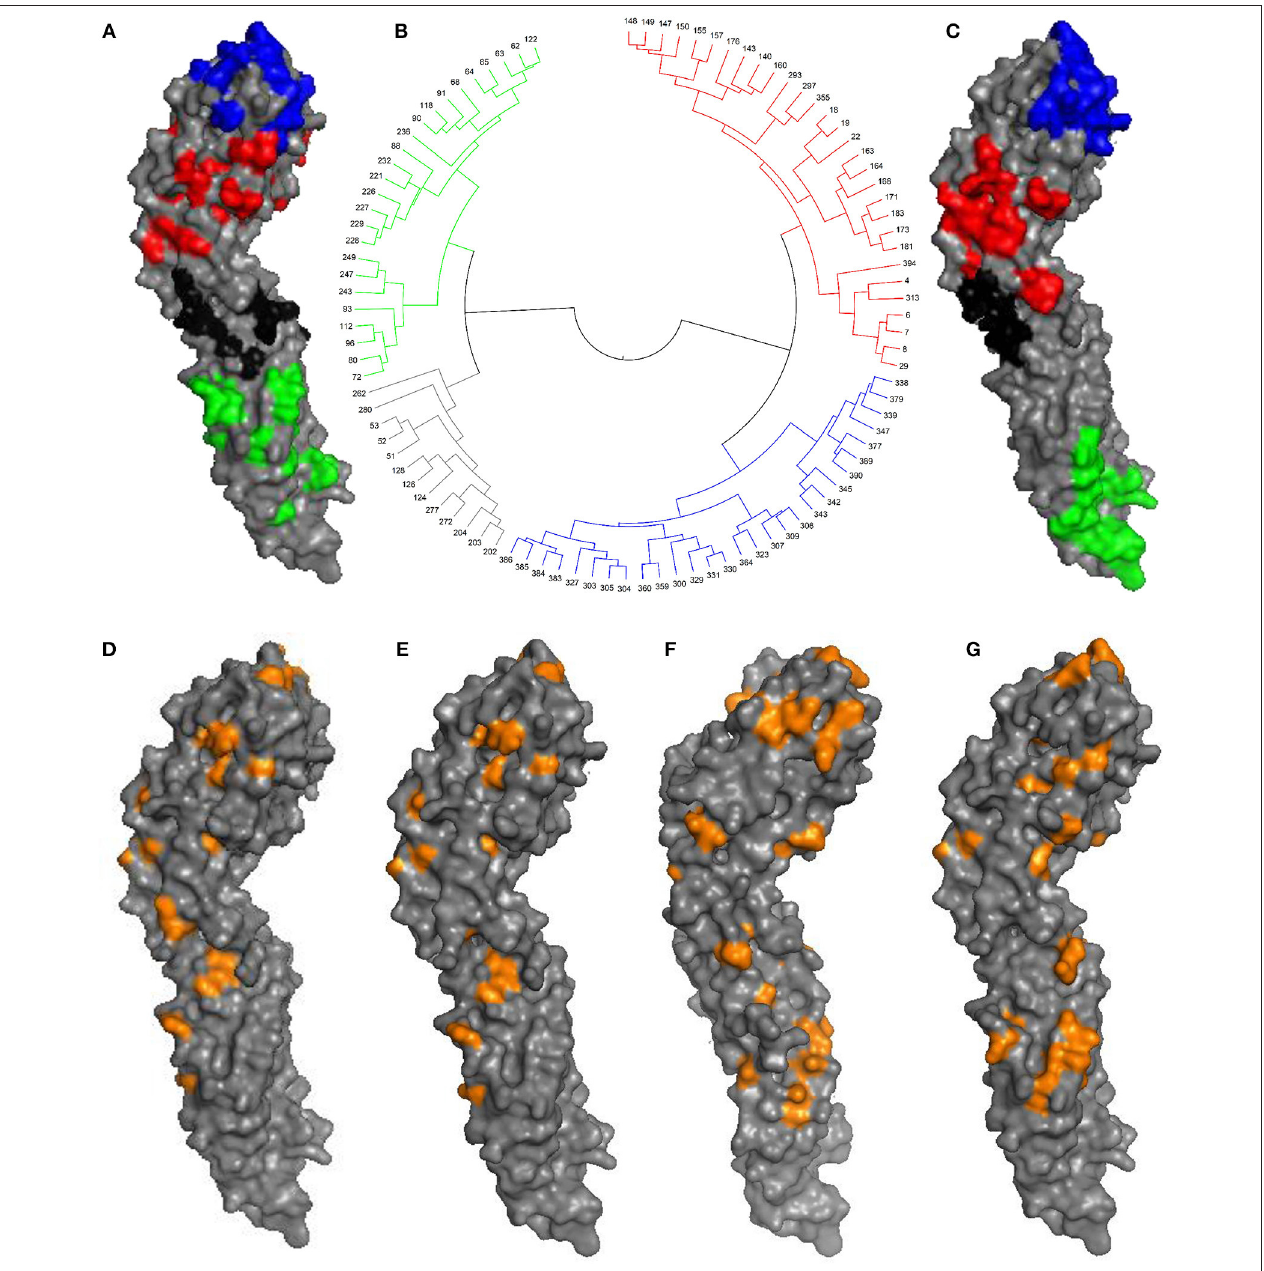
FIGURE 1 | Antigenic-dominant positions of DENV. (A) The 97 ADPs mapped on envelope (E) protein (PDB id: 1OAN). D1, D2, D3, and D4 patches were marked in blue, red, black, and green, respectively. (B) Clustering tree based on geometric distances between 97 ADPs, antigenic regions were marked with colors. (C) Broad-neutralizing epitope areas previously determined for E protein (Aaskov et al., 1989; Cockburn et al., 2012; Fibriansah et al., 2014, 2015). (D) 30 ADPs for DENV serotype 1. (E) 40 ADPs for DENV serotype 2. (F) 47 ADPs for DENV serotype 3. (G) 37 ADPs for DENV serotype 4.